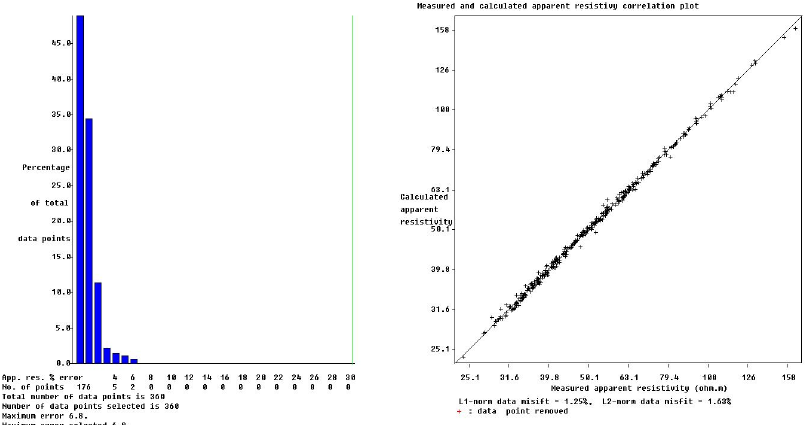
Figure 15. The results of the statistical analysis of errors in fitting the inversion model to the apparent resistivity distribution measured with the Wenner α array.